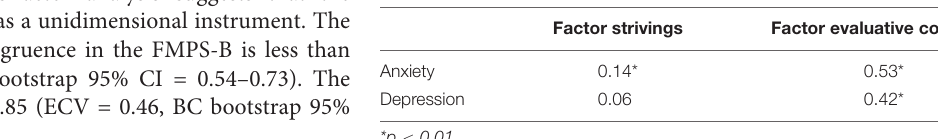
TABLE 6 | Correlations of factor strivings and evaluative concerns with measures of anxiety and